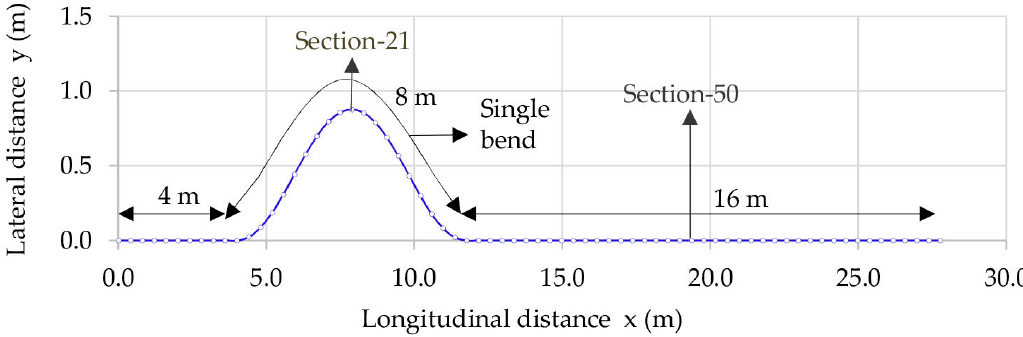
Figure 5. Top view of the initial channel centreline.